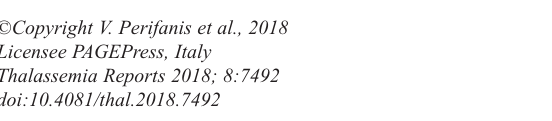
Figure 1. Logo of PIGI